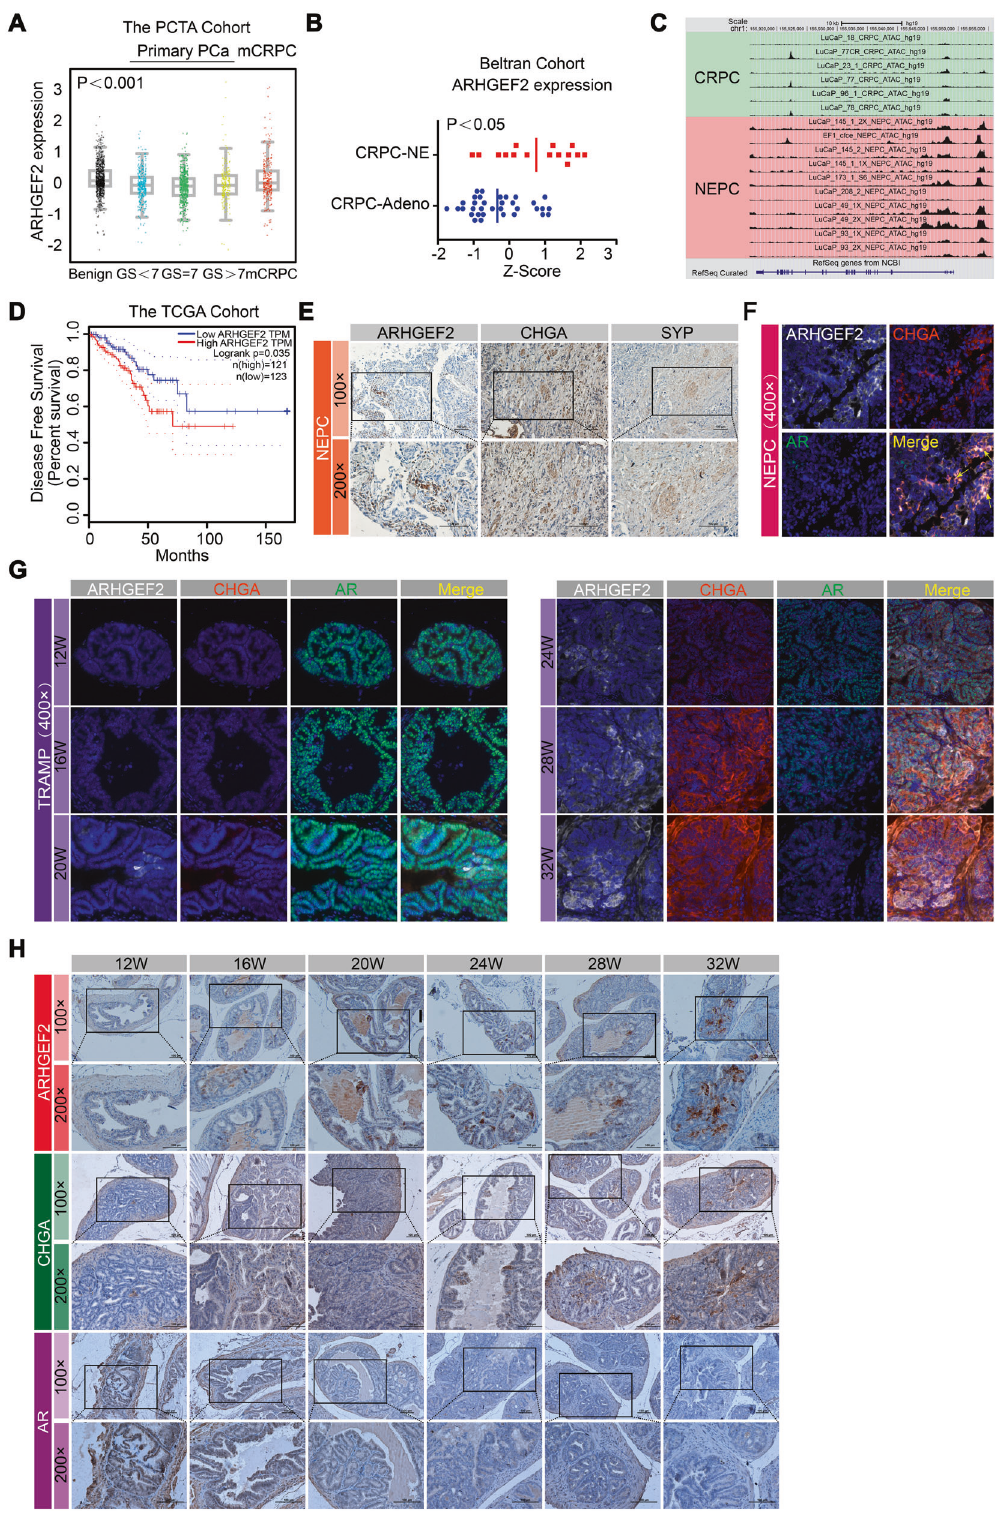
Fig. 1 ARHGEF2 highly expressed in neuroendocrine prostate cancer (NEPC). A The expression level of ARHGEF2 in the PCTA cohort [39]. B The expression level of ARHGEF2 in the Beltran cohort [20]. C Snapshot of the chromatin accessibility on the ARHGEF2 gene locus in both CRPC and NEPC tissues from a clinical cohort [41]. D Kaplan-Meier analysis of OS based on ARHGEF2 expression in the TCGA cohort [58]. E Representative images of ARHGEF2, CHGA, and SYP staining in NEPC patient tissue. F Immunoblot for ARHGEF2 (white), CHGA (red), and AR (green) in NEPC patient tissues. G Immunoblot for ARHGEF2 (white), CHGA (red), and AR (green) in TRAMP mice from prostate tissue acquired during different times (from 12 weeks to 32 weeks). H IHC analysis of ARHGEF2, CHGA, and AR expression in TRAMP mice from prostate tissue acquired during different times (from 12 weeks to 32 weeks). Data represent mean ± SD. For panel A Rank sums-test was applied. For panel B two-tailed unpaired Student ’ s t-test was applied; **** P ≤ 0.0001. Cell Death and Disease (2022)